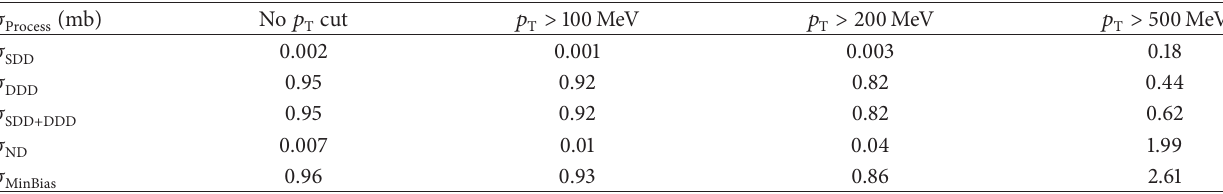
Table 5: Visible cross sections for different cuts on the transverse momentum of the final state particles in |𝜂| < 5.2 for Δ𝜂 > 4 cut. Gap is defined as central